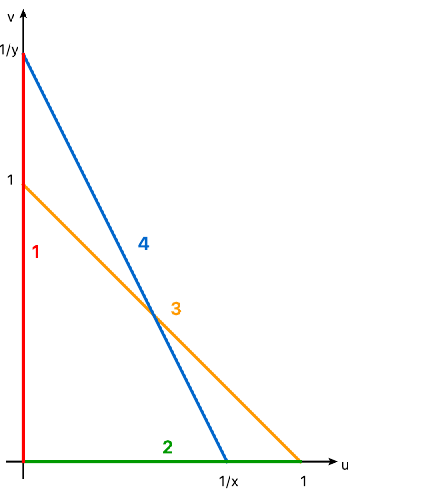
Figure 1 . Geometry for the two-dimensional integral representation of the Appell F 1 integral of eq.